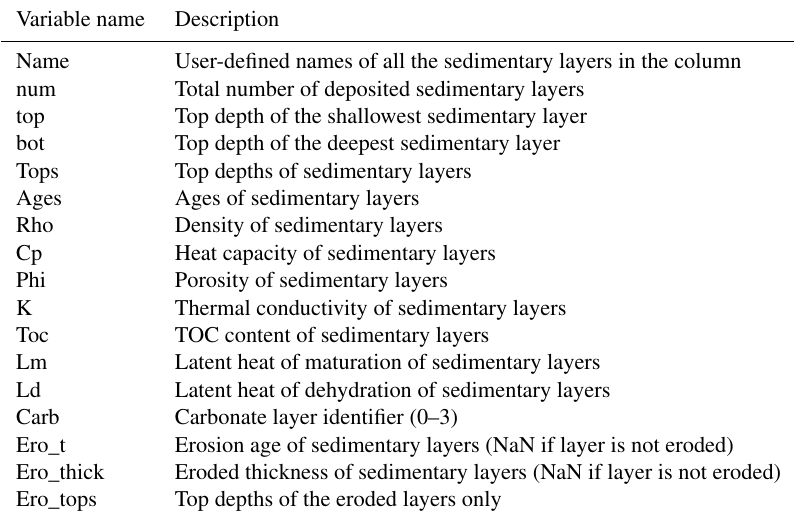
Table 2. List of variables in the “rock” struct variable of the output file.